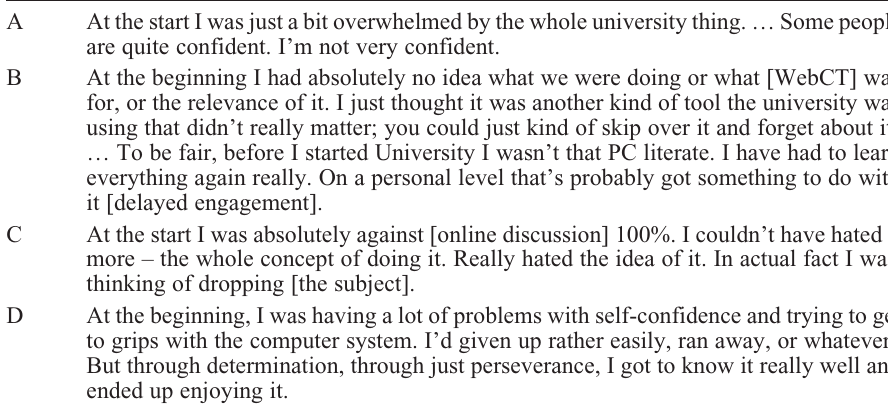
Table 3. Examples of feelings at the start of the